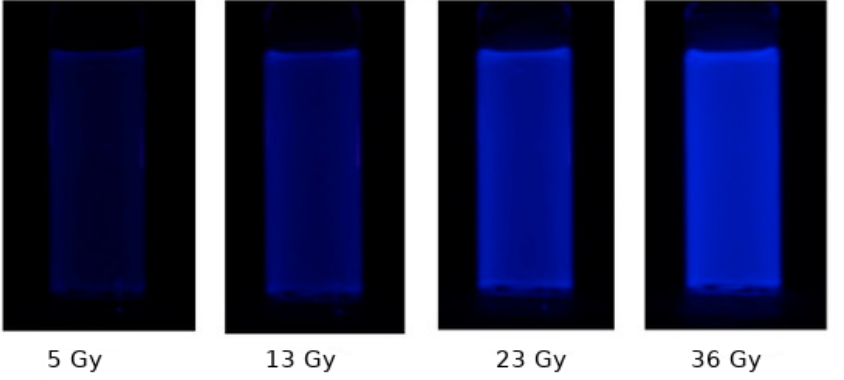
Figure 7. Examples of color fluorescence in UV light of maleimido-pyrene in tertiary-butyl acrylate, as a function of γ -photon dose. Adapted from